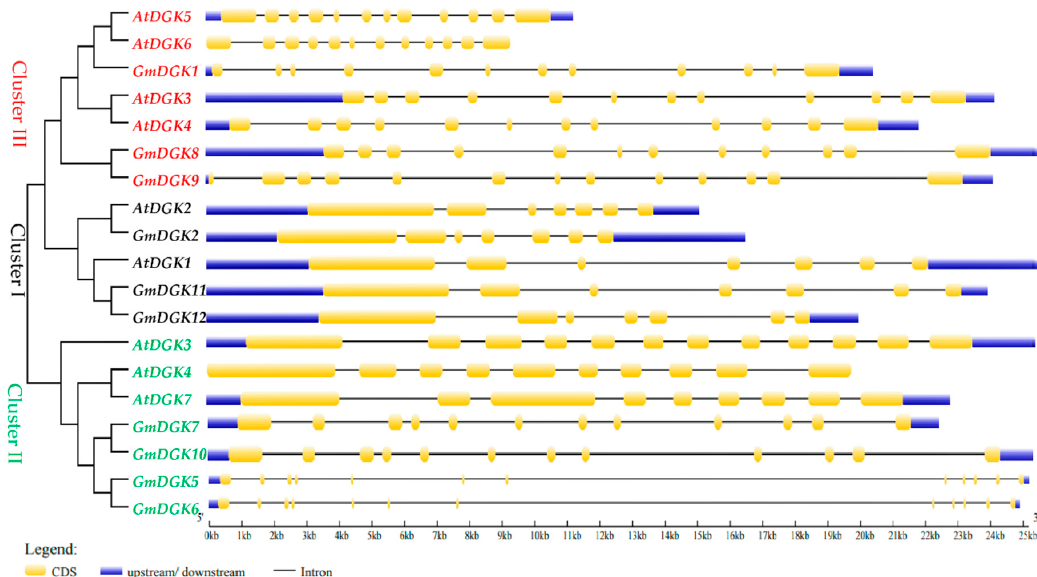
Figure 5. Phylogenetic intron/extron analysis, of the Arabidopsis and soybean DGK genes. Blue boxes represent upstream/downstream regions, gray lines represent introns, and yellow boxes represent exons.